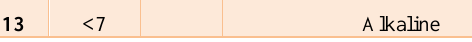
Table 2: Description of sodic land category